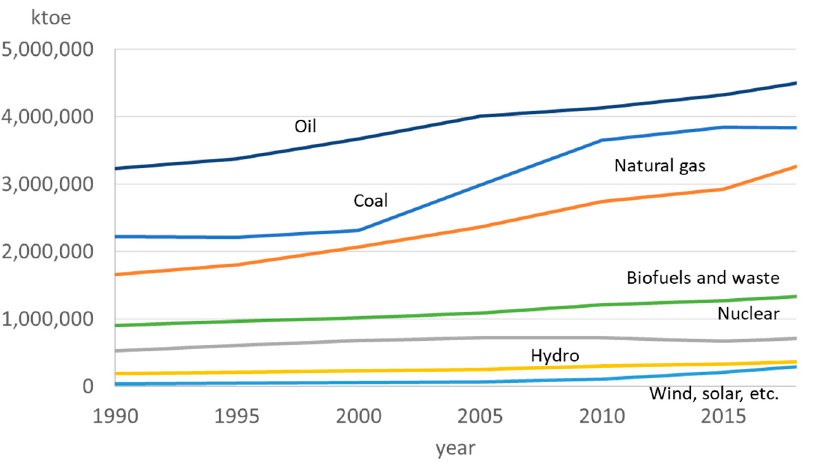
Figure 1. Total energy supply in ktoe in the world from 1990 to 2018. Extracted from IEA [1].